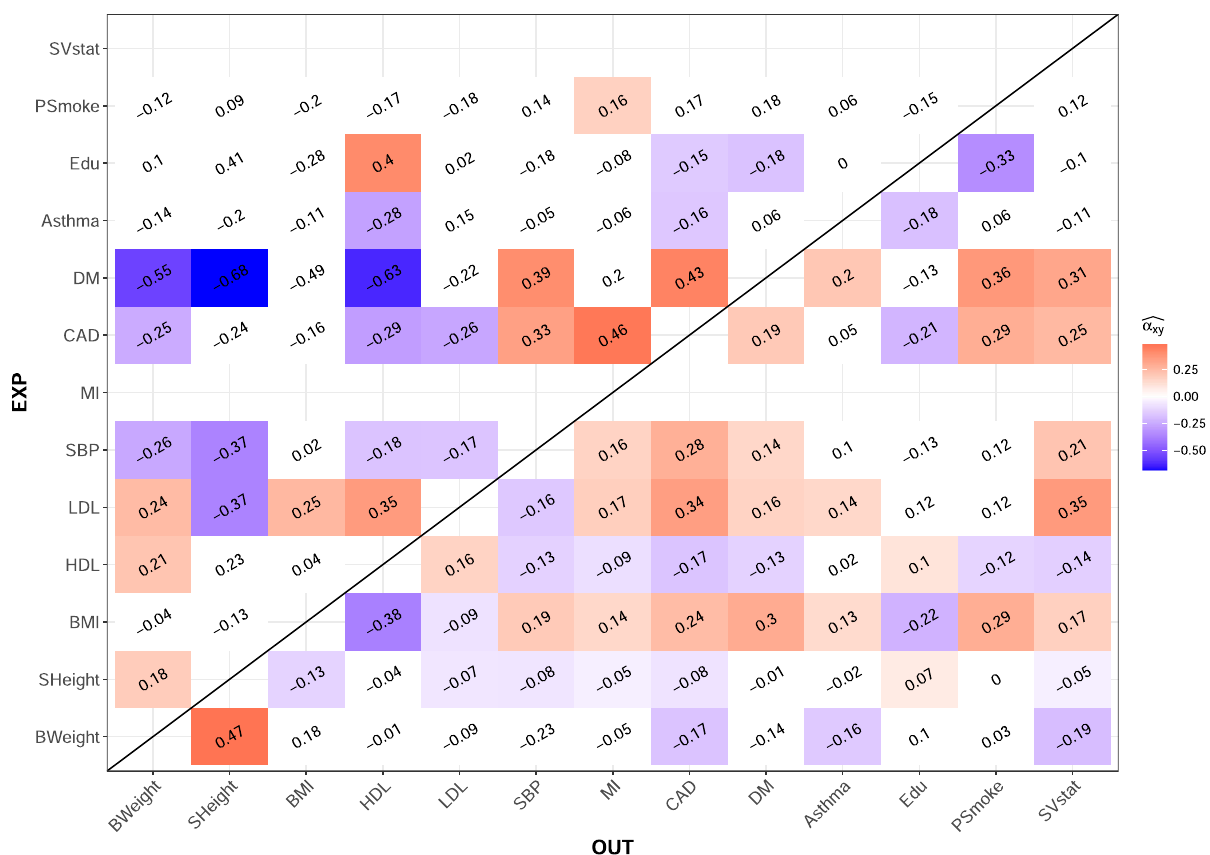
Fig. 4 Heatmap representing the bi-directional causal relationship between the 13 UK Biobank traits. The causal effect estimates in coloured tiles all have a signi fi cant p -value surviving Bonferroni multiple testing correction with a threshold of 3.2 × 10 − 4 . We did not report an estimated causal effect for exposures with an estimated total heritability less than 2.5%. White tiles show an absence of a signi fi cant causal effect estimate. BMI: Body Mass Index, BWeight: Birth Weight, CAD: Coronary Artery Disease, DM: Diabetes Mellitus, Edu: Years of Education, HDL: High-Density Lipoprotein, LDL: Low-Density Lipoprotein, MI: Myocardial Infarction, PSmoke: # of Cigarettes Previously Smoked, SBP: Systolic Blood Pressure, SHeight: Standing Height, SVstat: